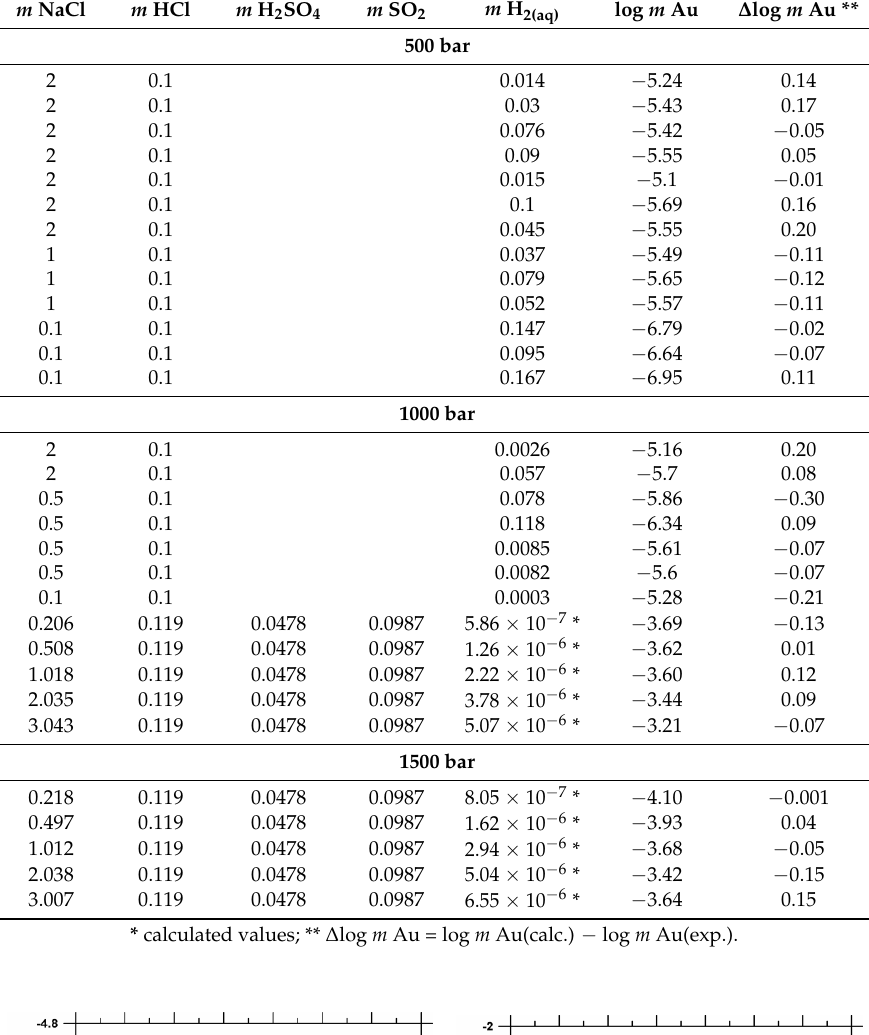
Table 1. Compositions of experimental solutions and results of Au solubility experiments (molal concentrations are given, mol (kg H 2 O) − 1 ), t = 450 °C, P from 500 to 1500 bar.